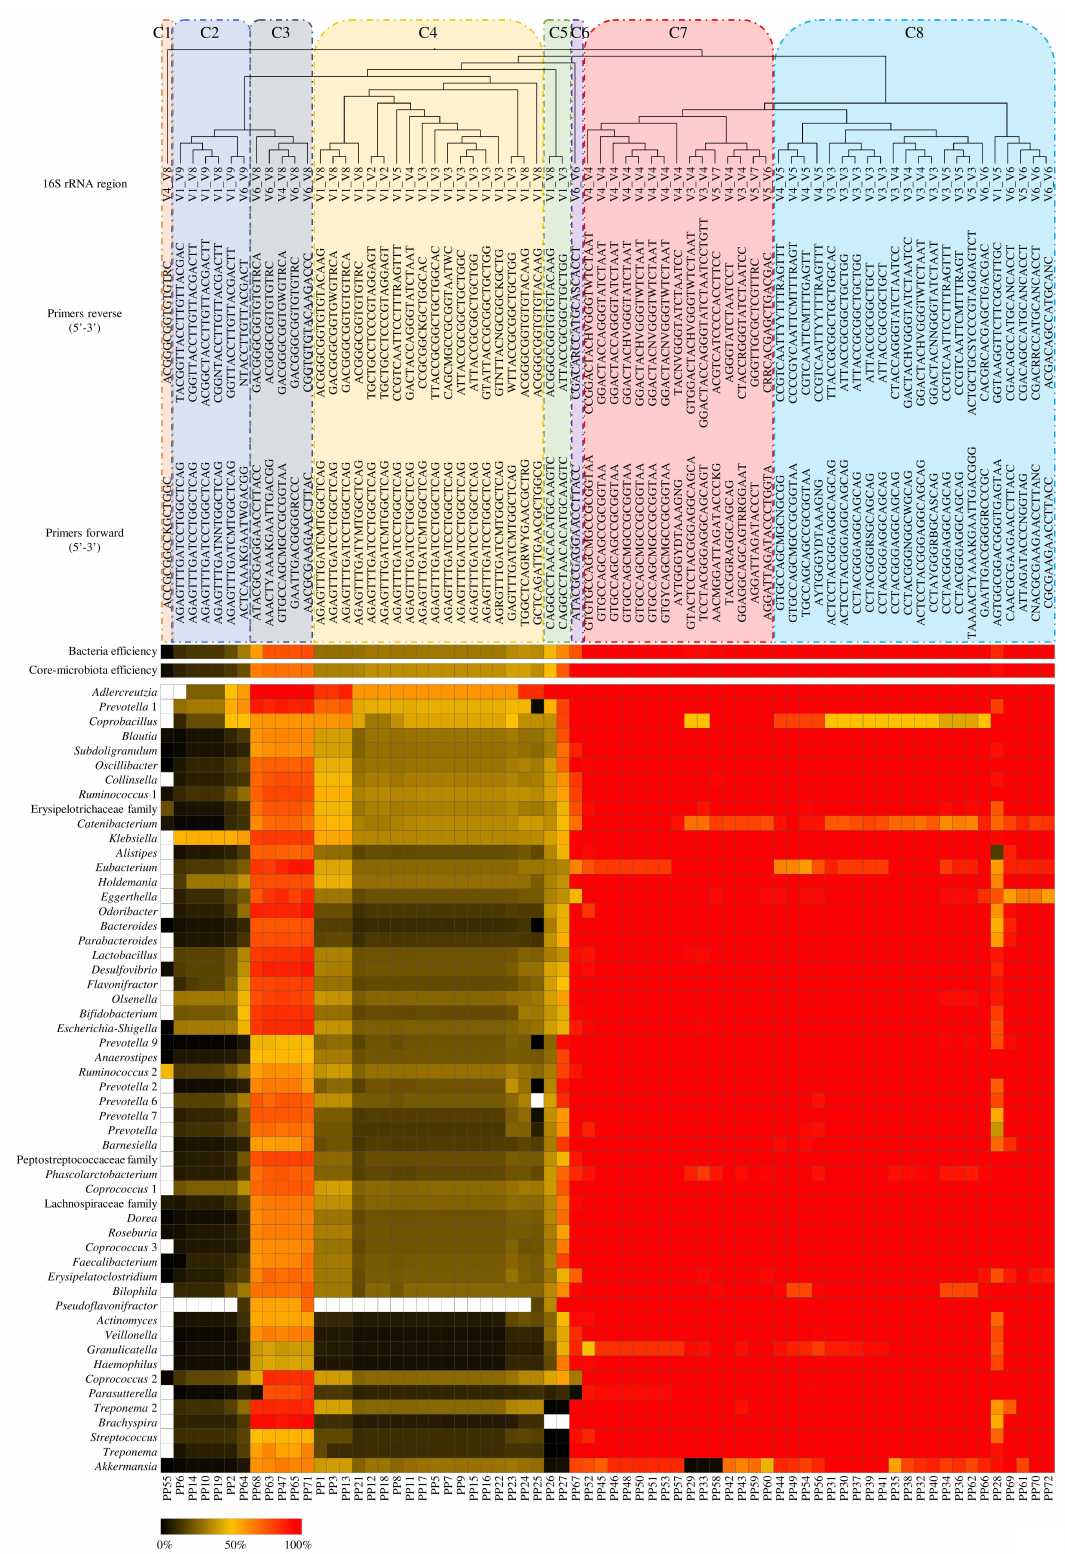
Figure 1. Amplification e ffi ciency of primer pairs as calculated by web-tool TestPrime 1.0. A heat map showing primer pair amplification e ffi ciency when targeting 54 bacterial taxa that are commonly found in the human gut microbiota. The PCR primer pair clusters were obtained by TM4 MeV software. The white cells indicate the inability of PCR primer pairs to amplify (members of) a bacterial